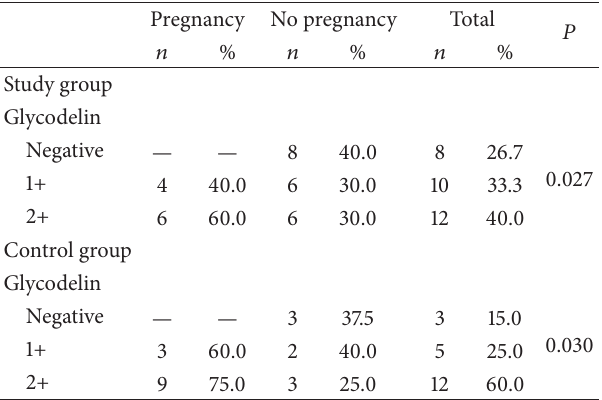
Table 2: Pregnancy rates within the study and control groups with respect to glycodelin